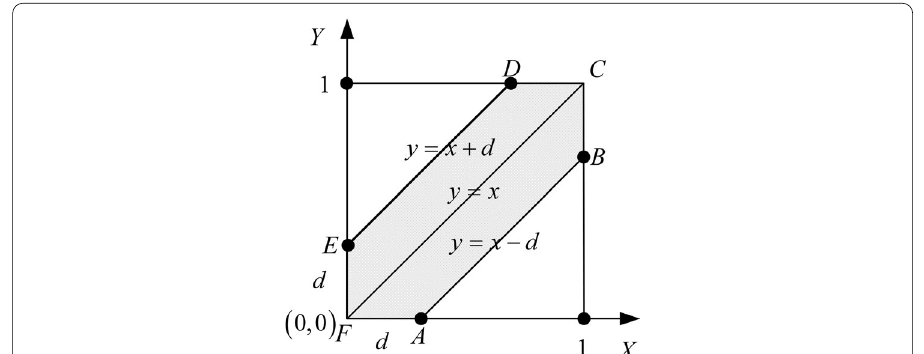
Fig. 3 The 2D form of ( 1 − P MFD ( d k , q )) which is the area of hexagon